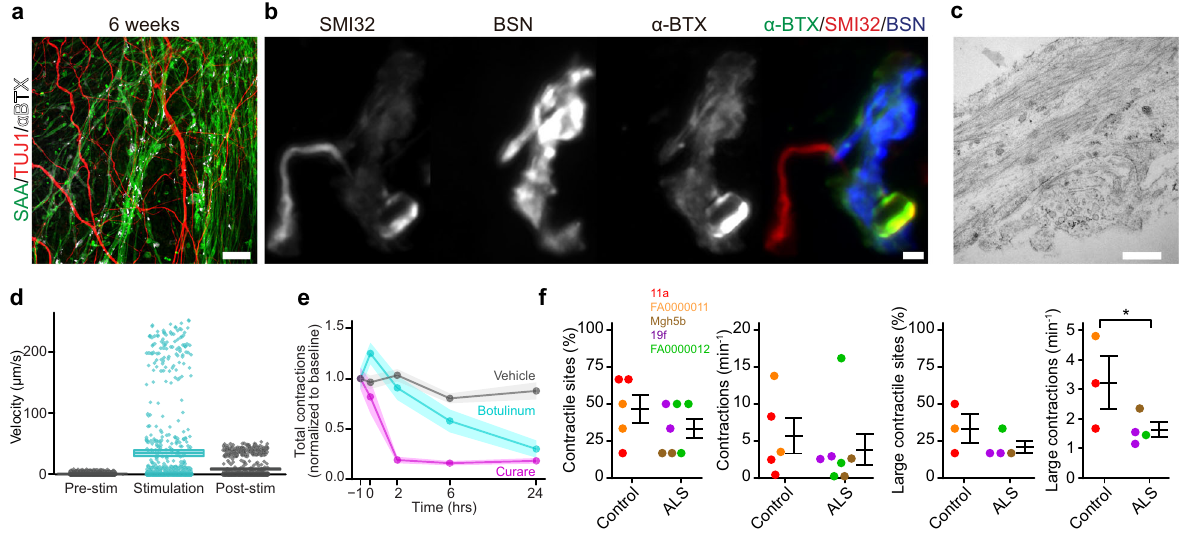
Fig. 5 Sensorimotor organoids form functional NMJs, which are impaired in ALS cultures. a TUJ1 + neurons juxtaposed with SAA + and α -bungarotoxin ( α BTX) + skeletal muscle at 6 weeks in culture. Scale bar, 100 µ m. b NMJs at high magni fi cation depicting SMI32 + neuronal terminals and presynaptic BSN staining that abuts postsynaptic α BTX staining. Scale bar, 2 µ m. c Electron micrograph of an NMJ showing synaptic densities that separate presynaptic vesicles (bottom right) from longitudinally cut muscle fi bers (top) at 9 weeks in culture. Scale bar, 500 nm. d Quanti fi cation of muscle contraction triggered by optogenetic activation of neurons. Neurons expressing hSYN ::ChR2 evoke the rapid movement of muscle fi bers when stimulated with blue light. e Pharmacology of muscle contractions in sensorimotor organoids. Spontaneous muscle contractions in 8-week-old cultures are inhibited by curare and botulinum toxin, the latter indicating dependence on synaptic function. Inhibition of contractions by each drug was assessed in fi ve independent biological differentiation replicates of four iPSC lines (11a, MGH5b, 19f, and FA0000012). Plots show mean and 95% con fi dence intervals as line and shaded area, respectively. f Unbiased analysis of contraction site and frequency. Skeletal muscle contractions at six sites per organoid culture were counted and pooled from three independent biological differentiation replicates of fi ve iPSC lines at 7 – 8 weeks. Percentage of contractile sites and contraction frequency per organoid culture were quanti fi ed separately for all contractions (left two panels, n = 5 control, and 7 ALS organoids; contractile sites: two- sided ANOVA type 3, F = 1.458, P = 0.255; all contractions: two-sided ANOVA type 3, F = 0.343, P = 0.571), and large contractions (right two panels, n = 3 control, and 4 ALS organoid cultures, large contractile sites: two-sided ANOVA type 3, F = 1.7532, P = 0.243; large contractions: two-sided ANOVA type 3, F = 8.289, P = 0.035). iPSC lines: 11a (red), FA0000011 (orange), MGH5b (brown), 19f (purple), and FA000012 (green). Bars indicate mean and